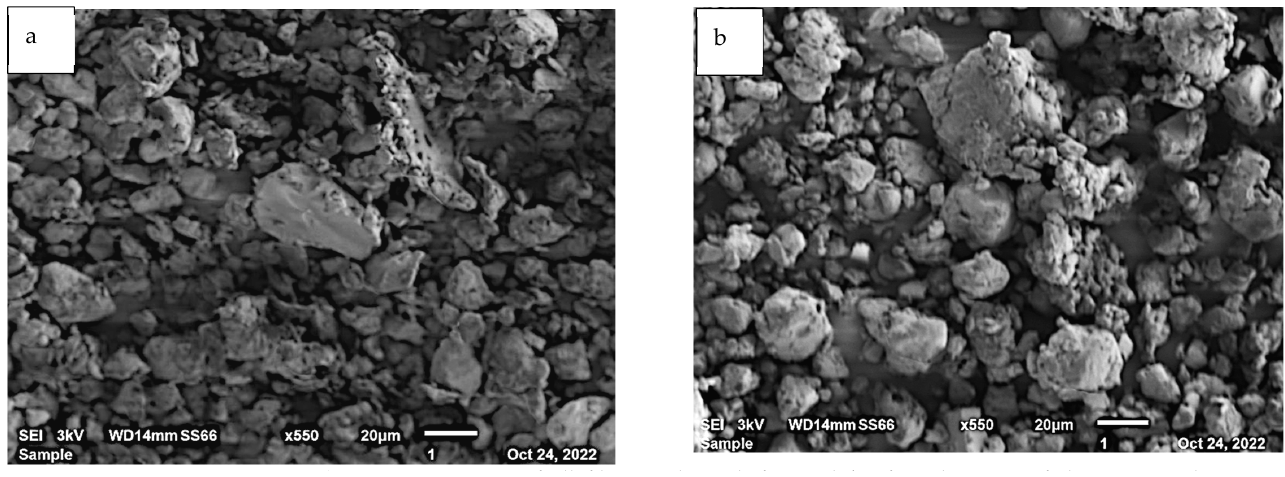
Figure 3. SEM images of silk film powder ( a ) before and ( b ) after adsorption of pharmaceuticals. 3.2. Effect of pH The results of the effect of pH on the adsorption of the selected pharmaceuticals are presented in Figure 4. Under strongly acidic conditions (pH 2) the adsorption of pindolol, caffeine, and nevirapine was < 100 μ g g − 1 , 200 μ g g − 1 < carbamazepine, prednisolone < 300 μ g g − 1 , 300 μ g g − 1 < naproxen, and estriol < 500 μ g g − 1 . Increasing the pH of the solution to slightly acidic (pH 4) did not affect the adsorption of naproxen while some improvements were observed in the adsorption of estriol, pindolol, prednisolone, carbamazepine, and nevirapine. A slight decline in the adsorption of lidocaine and caffeine was also observed. Under weak acidic conditions (pH 6), there was a noticeable increase in the adsorption of pindolol while no major changes were observed for the rest of the drugs. When the